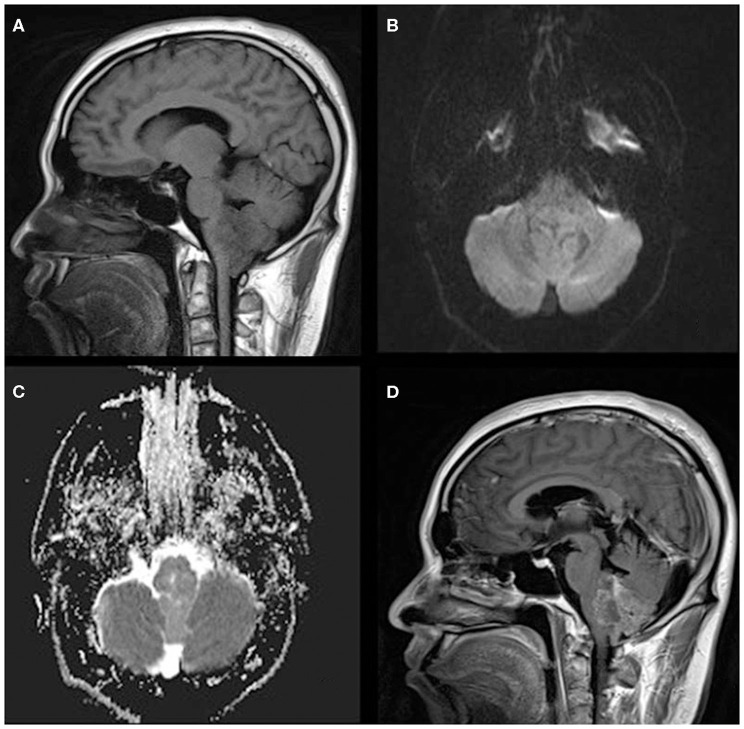
A 33-year-old man with infratentorial anaplastic ependymoma in the fourth ventricle on (A) T1-weighted image, (B) diffusion-weighted images, (C) apparent diffusion coefficient, and (D) contrast T1-weighted image. The tumor appears as heterogeneous signal intensity, small cysts, non-reduced diffusion within the soft tissue component, and absent peritumoral edema.